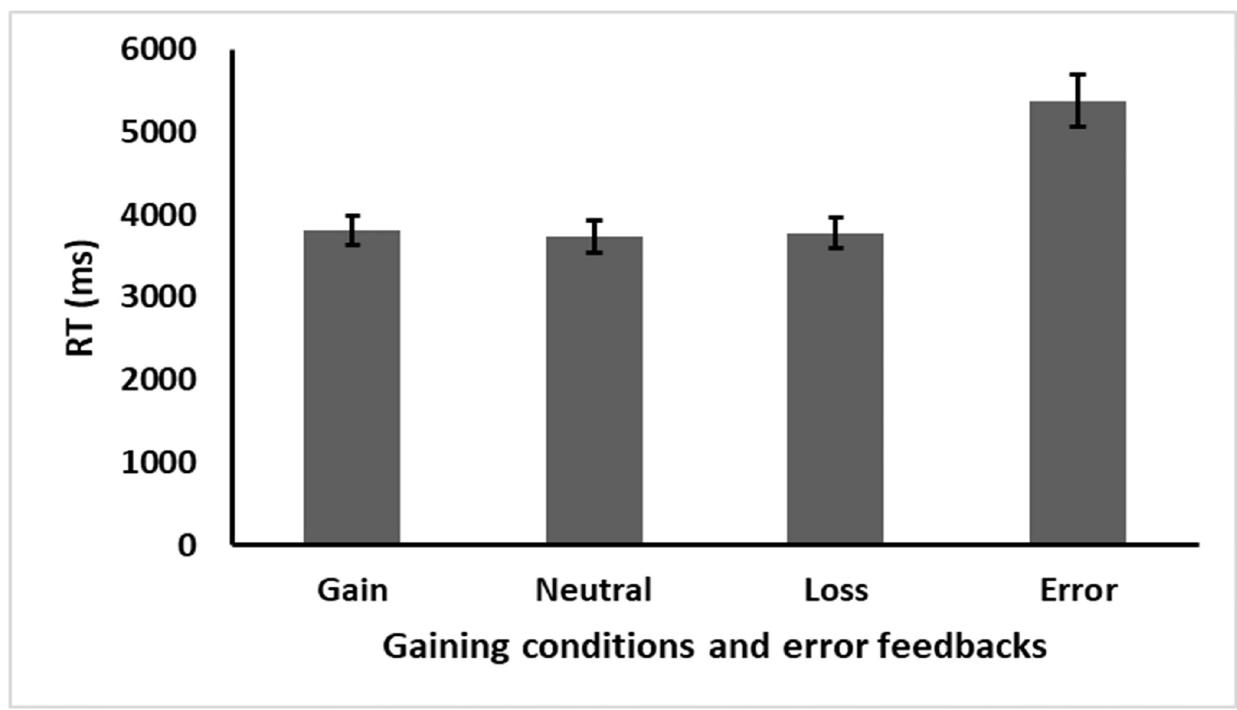
Fig 2. Experiment 1 results. Performance after the different gaining conditions (performance in trial n+1). Error bars represent standard error.